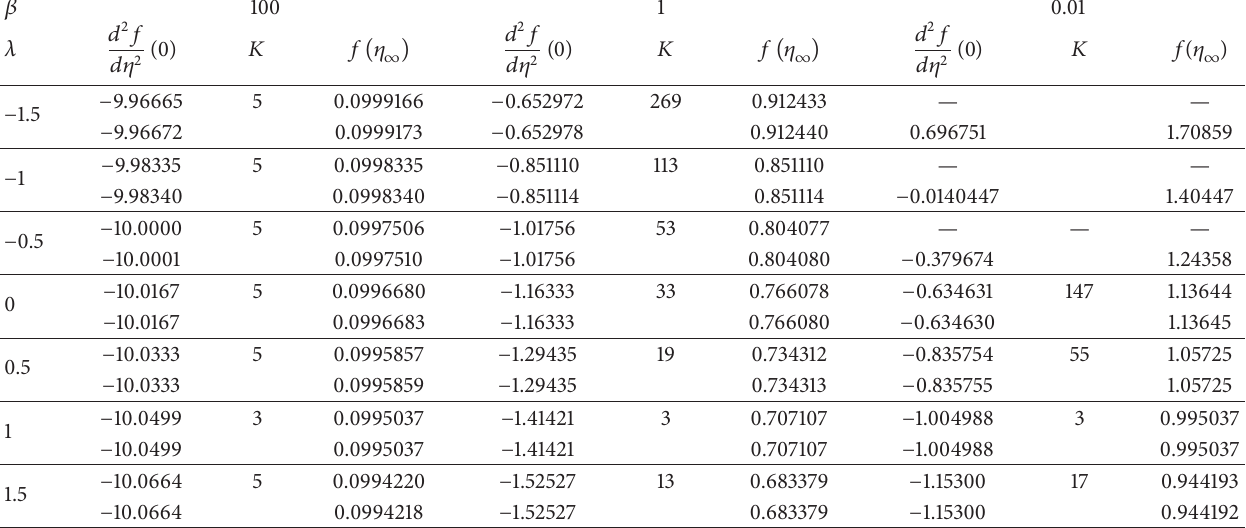
Table 3: Validity of the expansion solution at different values of 𝛽 and 𝜆 < 2 , 𝛾 = 0 .